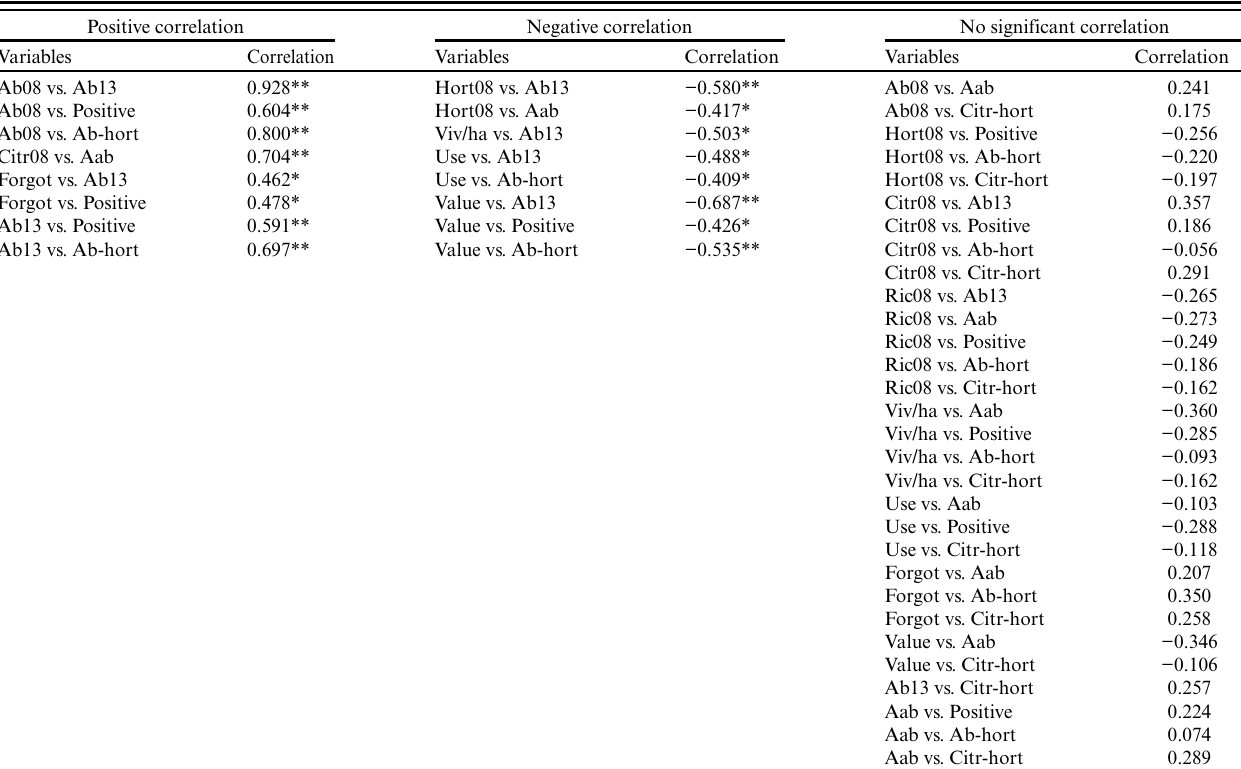
Table 2. Pearson correlations between factors that are assumed to promote resilience and the two dimensions of resilience (persistence and adaptability) with respect to landscape character areas. Abbreviations: Aab = speed of abandonment, Ab08 = rate of abandonment in 2008, Ab13 = rate of abandonment in 2013, Ab-hort = proportion of reversion to arable land, Citr08 = proportion of citrus in 2008, Citr-hort = proportion of conversion to arable land, Hort08 = proportion of herbaceous crops in 2008, Forgot = level of forgottenness in 2008, Positive = incidence of positive changes, Ric08 = proportion of rice in 2008, Use = social use in 2008, Value = social value in 2008, Viv/ha = density of dwellings in